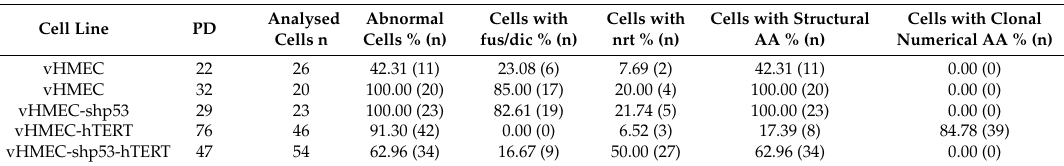
Table 1. Cytogenetic analysis in the different vHMEC cell lines.